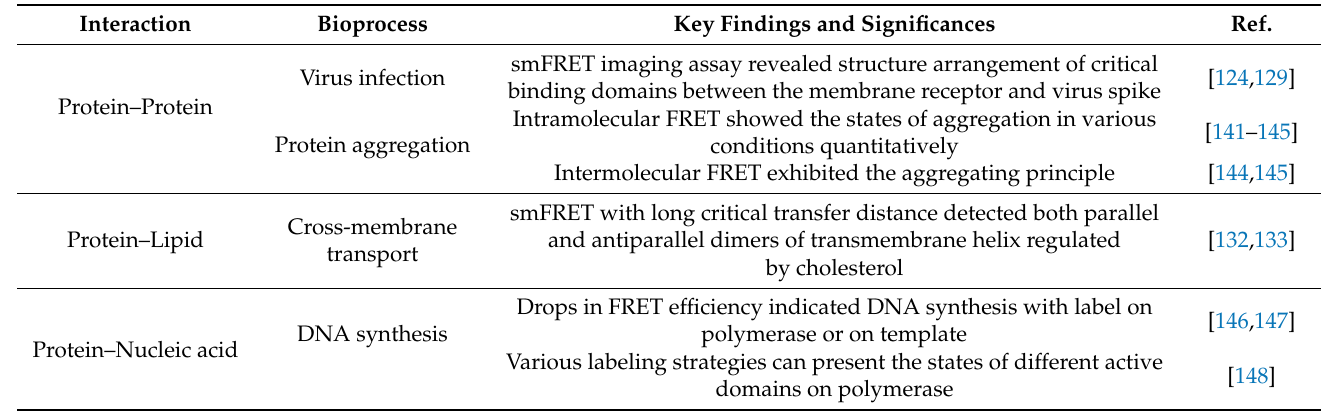
Table 2. Representative smFRET studies on the interactions among